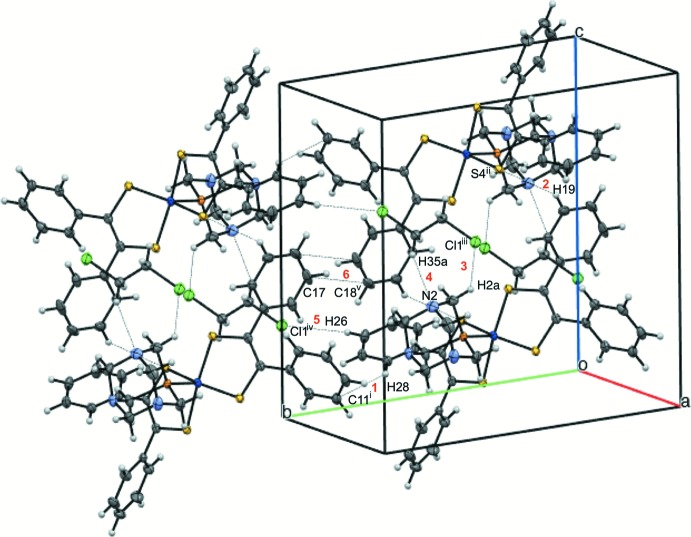
View of two mol­ecules of [Co(C14H10S2)2(C6H12N3P)]·0.5C2H4Cl2 within the unit cell and one additional translation of the unit cell along b, at 50% probability ellipsoids. Close contacts, including hydrogen bonds are labeled 1–6 with distances given in Table 1 ▸.